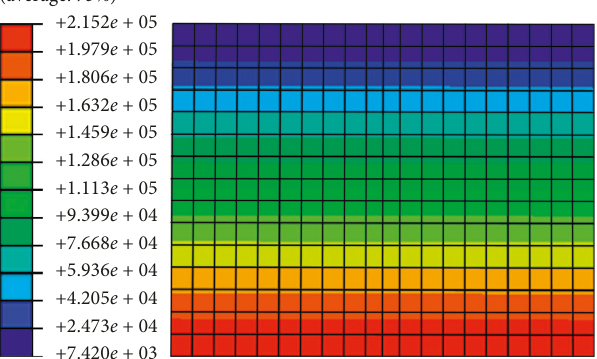
Figure 7: Initial stress cloud map.